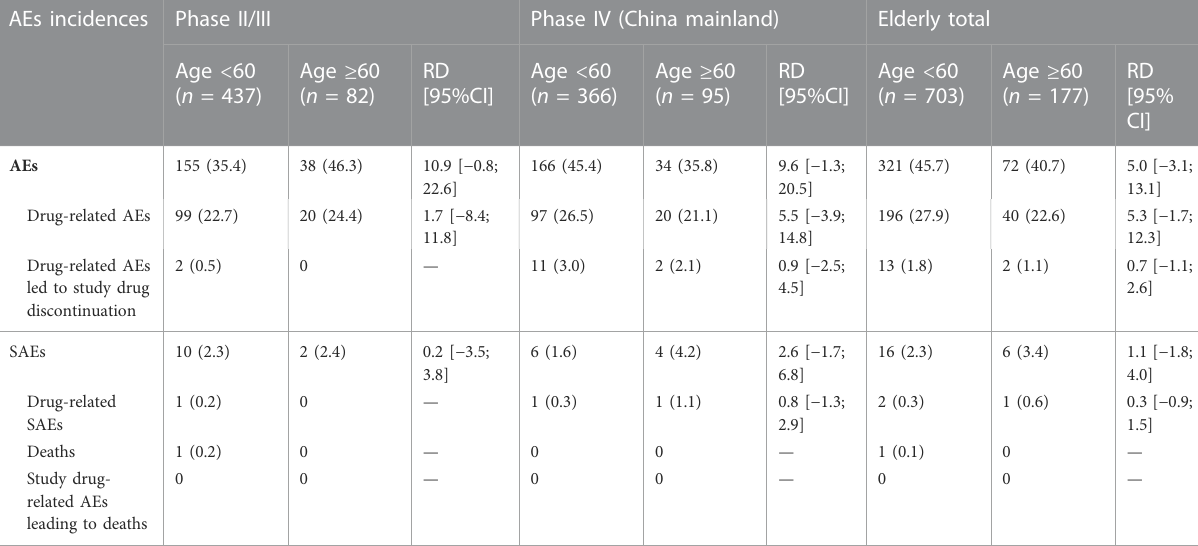
TABLE 8 Summary of nemonoxacin 500 mg safety in Phase II – IV studies strati fi ed by the age of